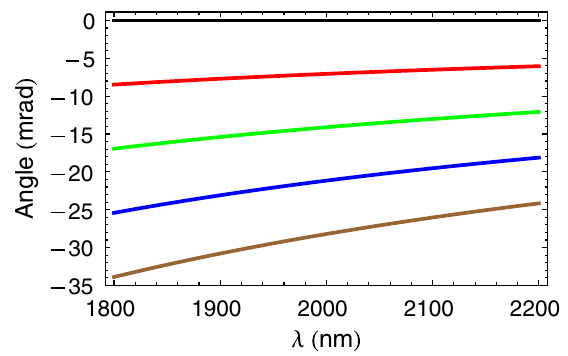
FIG. 3. Angular dispersion of the idler beam in the first BBO OPCPA stage, for various noncollinear angles: 0 (cid:6) -black, 2 (cid:6) -red, 3 (cid:6) -green, 4 (cid:6) -blue, 5 (cid:6) -brown.